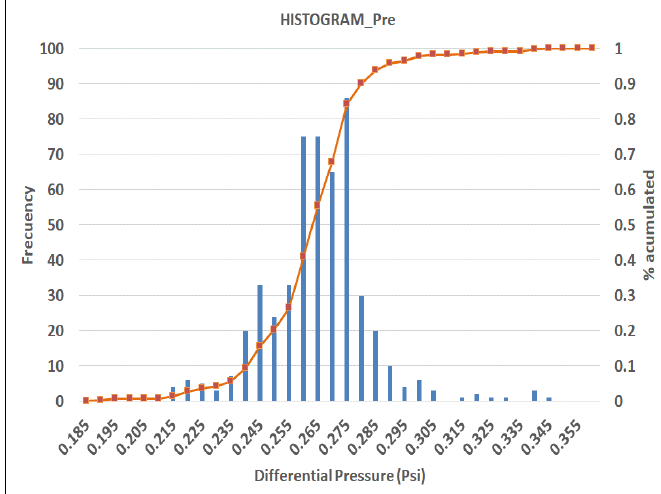
Figure 5: Distribution of pressure differential values (Phase 1).